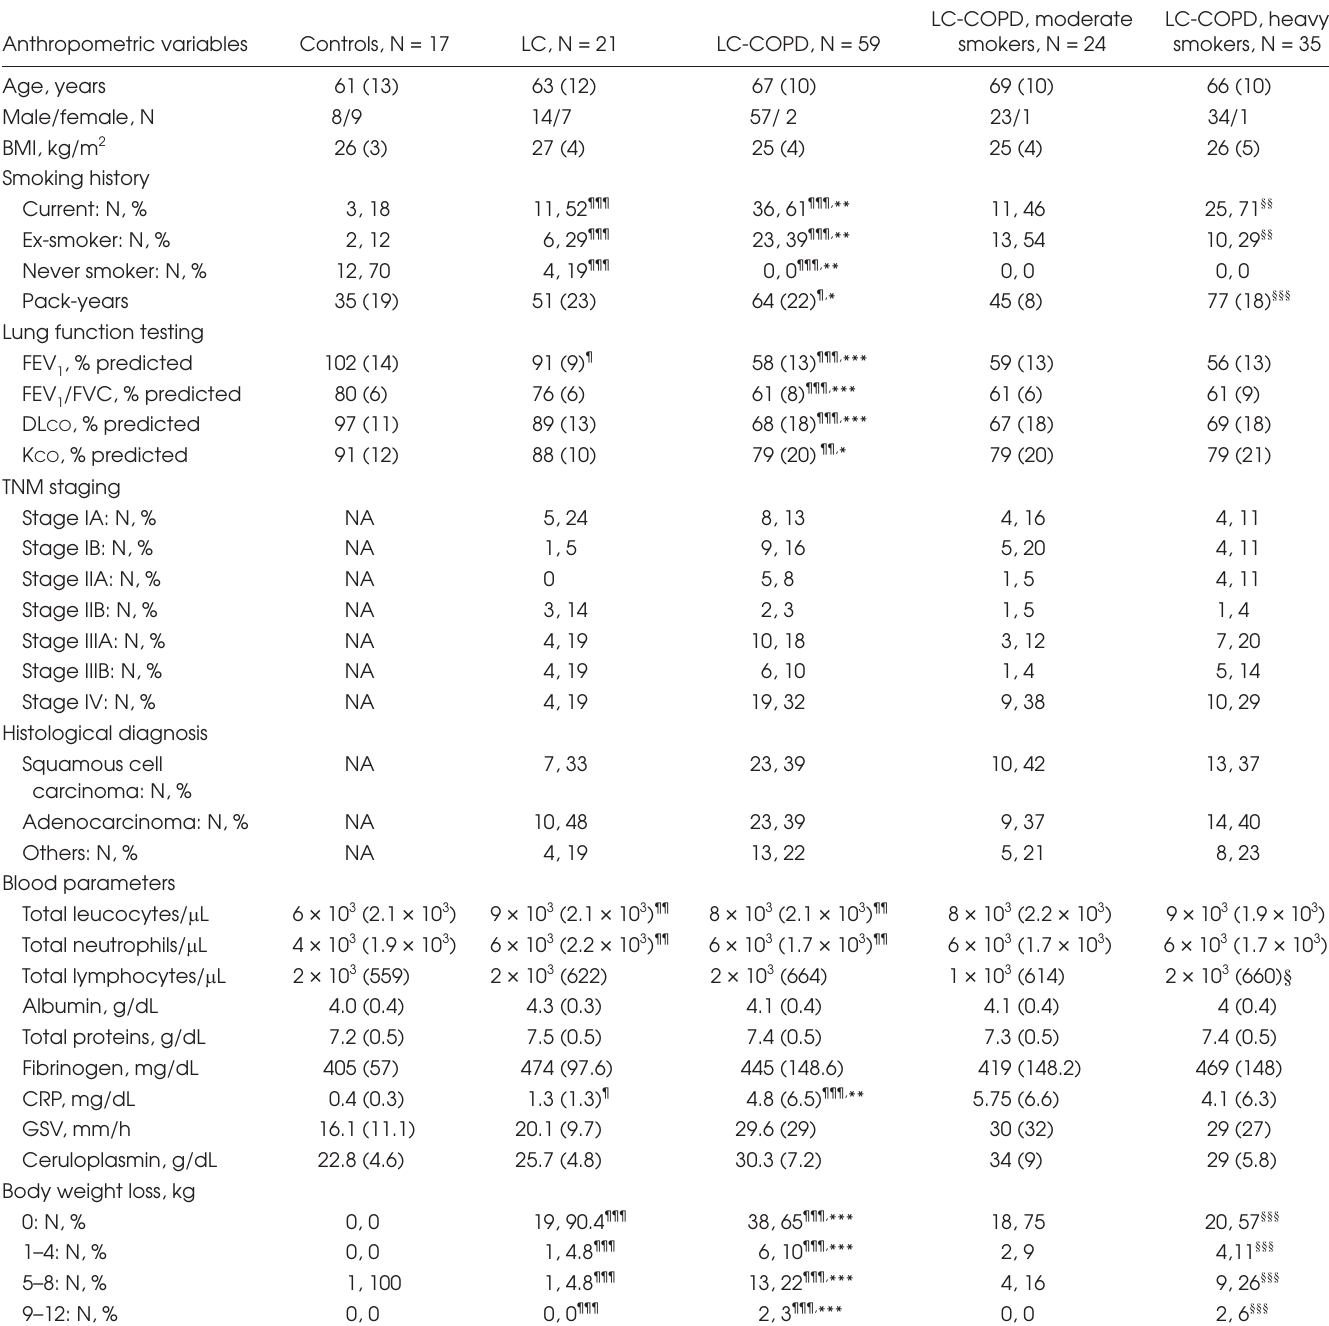
table 1. Clinical and functional characteristics of all the study patients. a,b